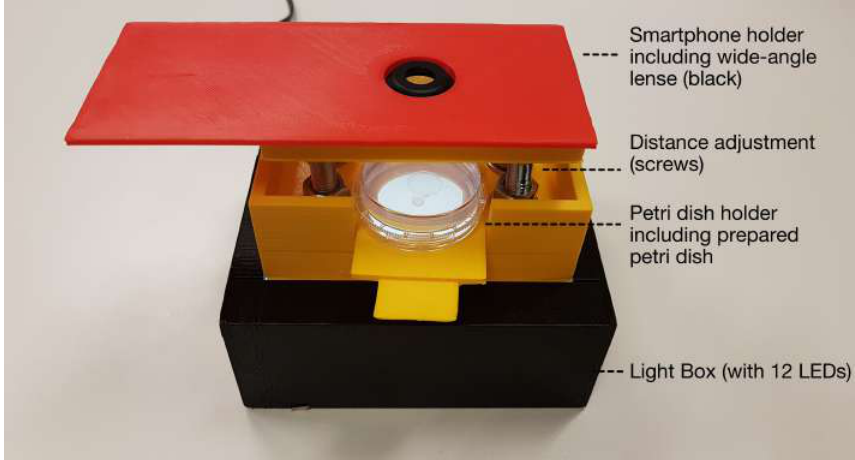
Figure 4. Developed microscope-prototype housing (screws were lifted for demonstration purposes, gap between smartphone holder and Petri dish holder is closed during operation).